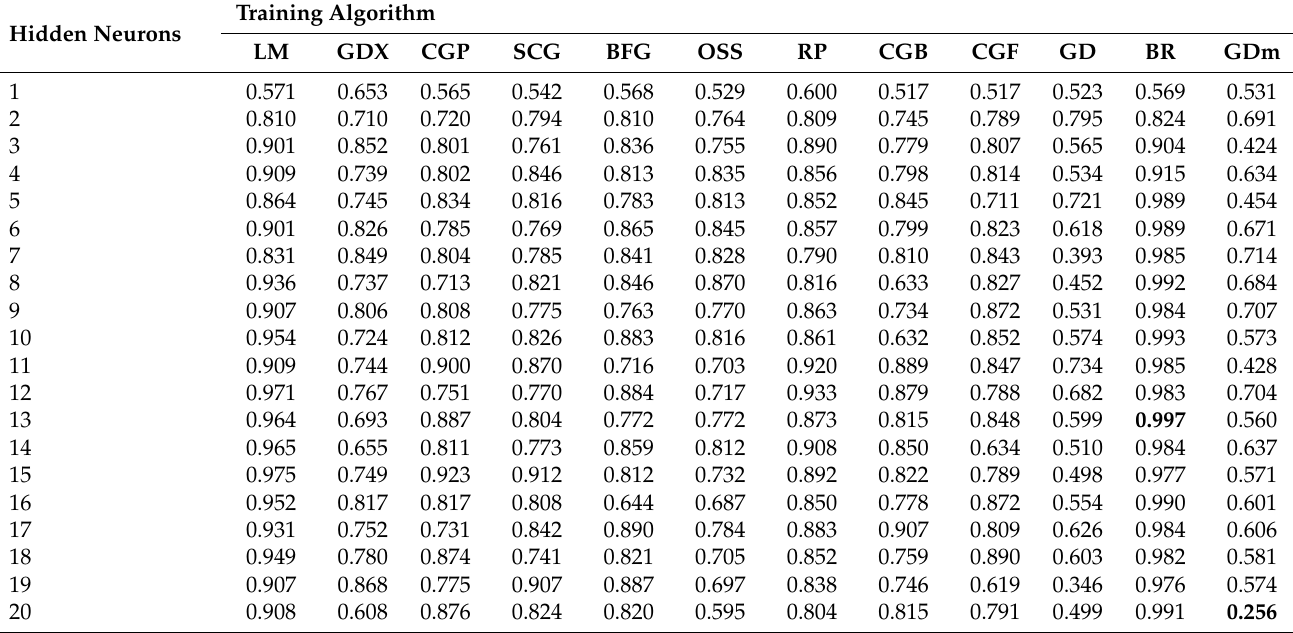
Table A11. R value for CH4 percentage in biogas for different training algorithms at different number of hidden neurons.